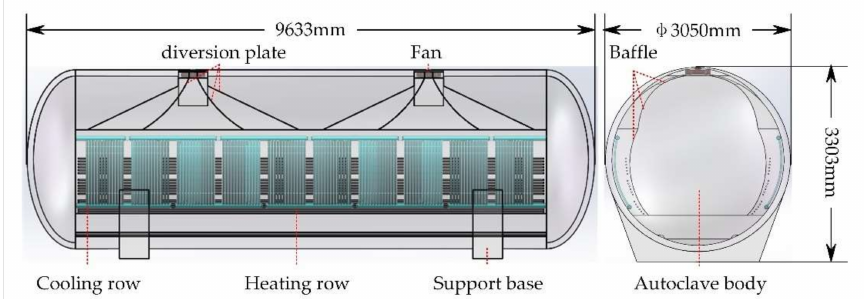
Figure 1. Structure diagram of